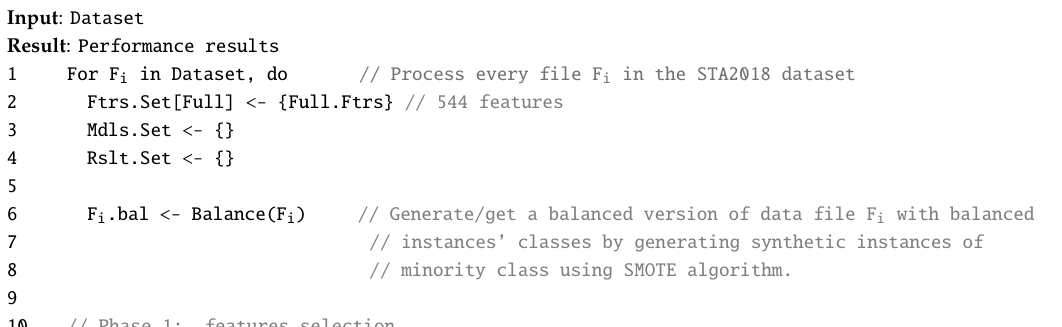
Algorithm 2: Experiment Phases (pseudo code)